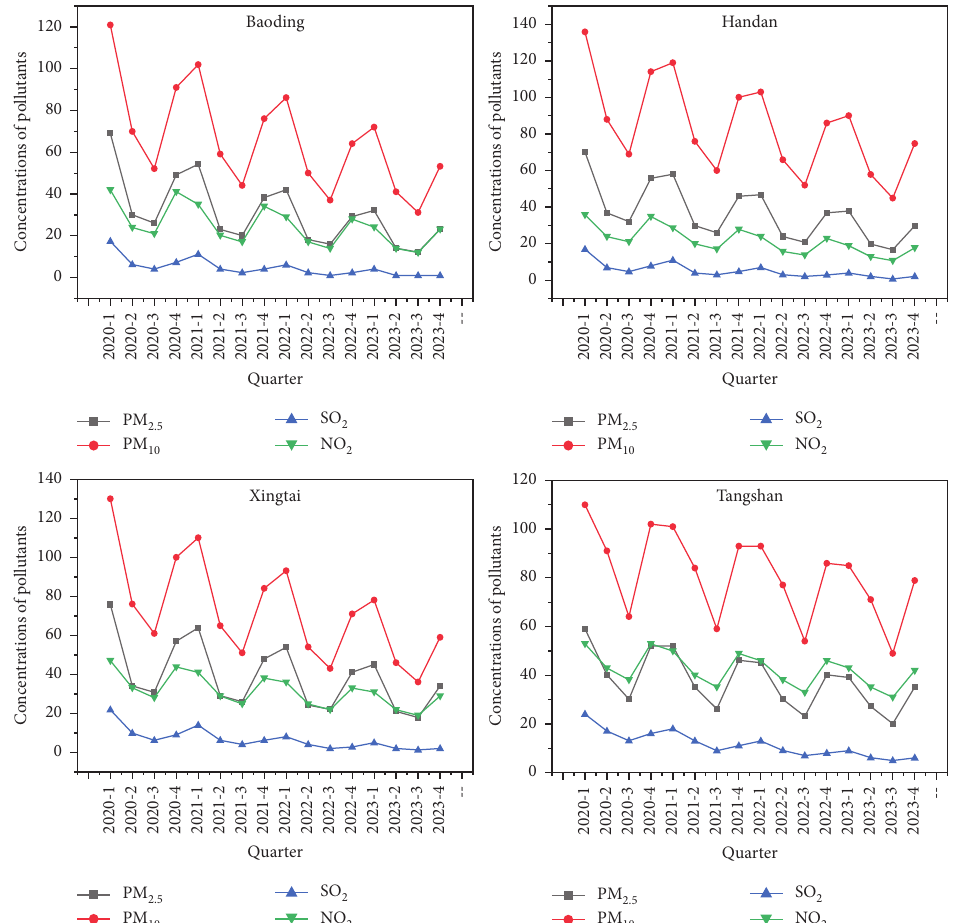
Figure 3: The predicted concentrations of four pollutants in four cities in Hebei